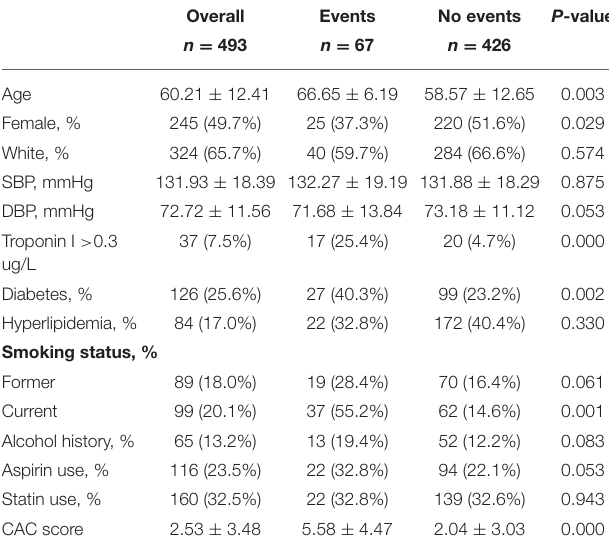
TABLE 1 | Baseline characteristics for all patients with Events and no